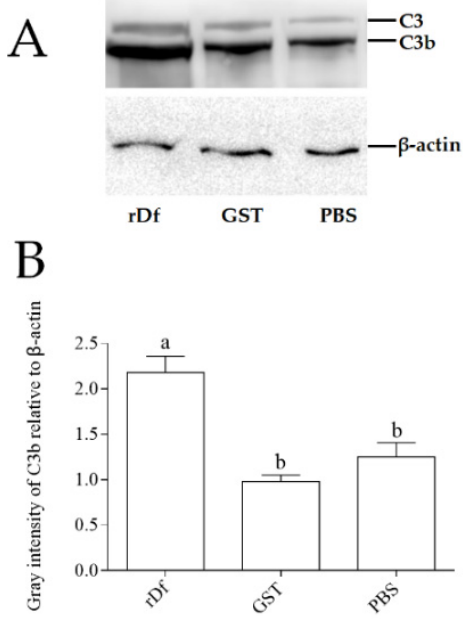
Figure 8. r Ci Df activity promotes C3 cleavage in grass carp serum. ( A ) Western blotting analysis of C3 protein cleavage. Bands of C3 and C3b protein were imaged via the GeneSys Imaging System. β -actin was used as internal reference protein. ( B ) Gray intensity analysis of the C3b protein in grass carp serum using ImageJ. The letters a and b indicate significant differences among groups ( p < 0.05).